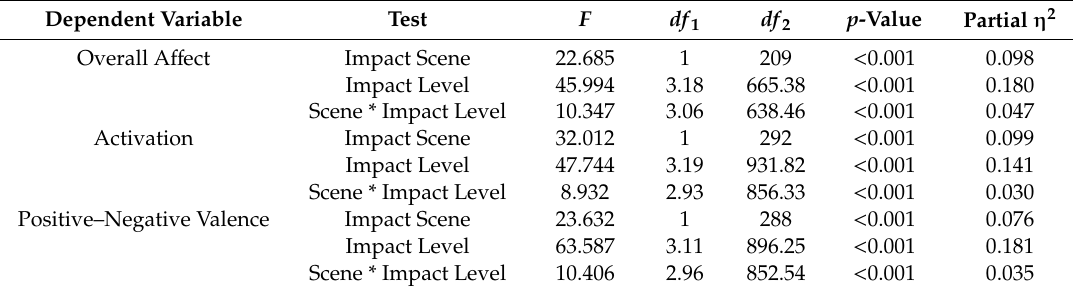
Table 1. Repeated measures ANOVA for overall a ff ect, activation, and positive–negative valence 1 .